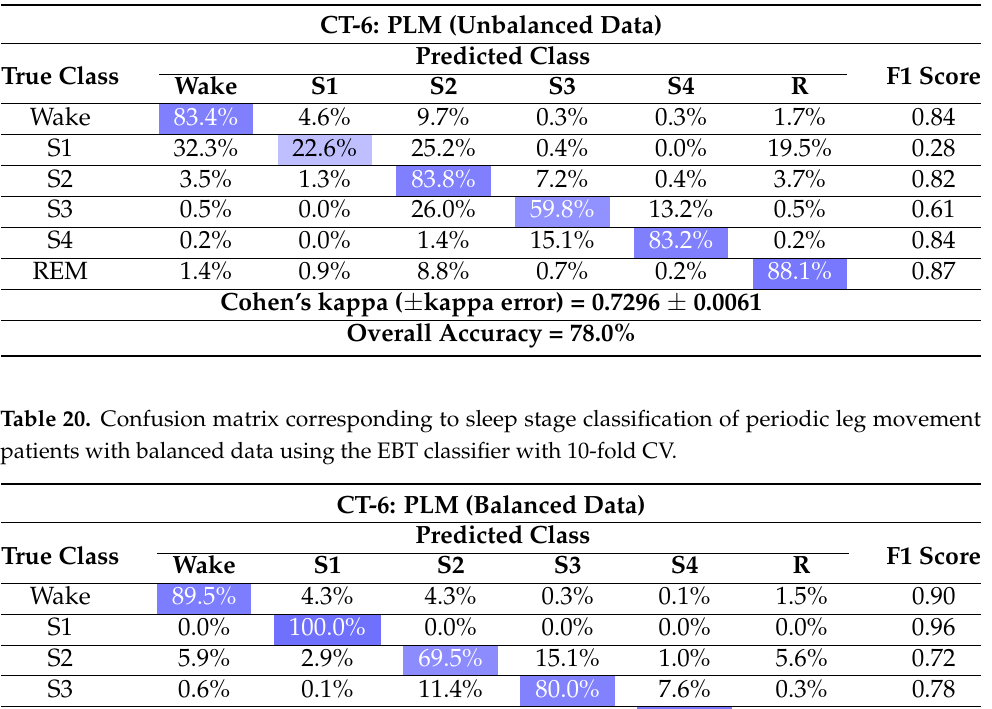
Table 19. Confusion matrix corresponding to sleep stage classification of periodic leg movement patients with unbalanced data using the EBT classifier with 10-fold CV.